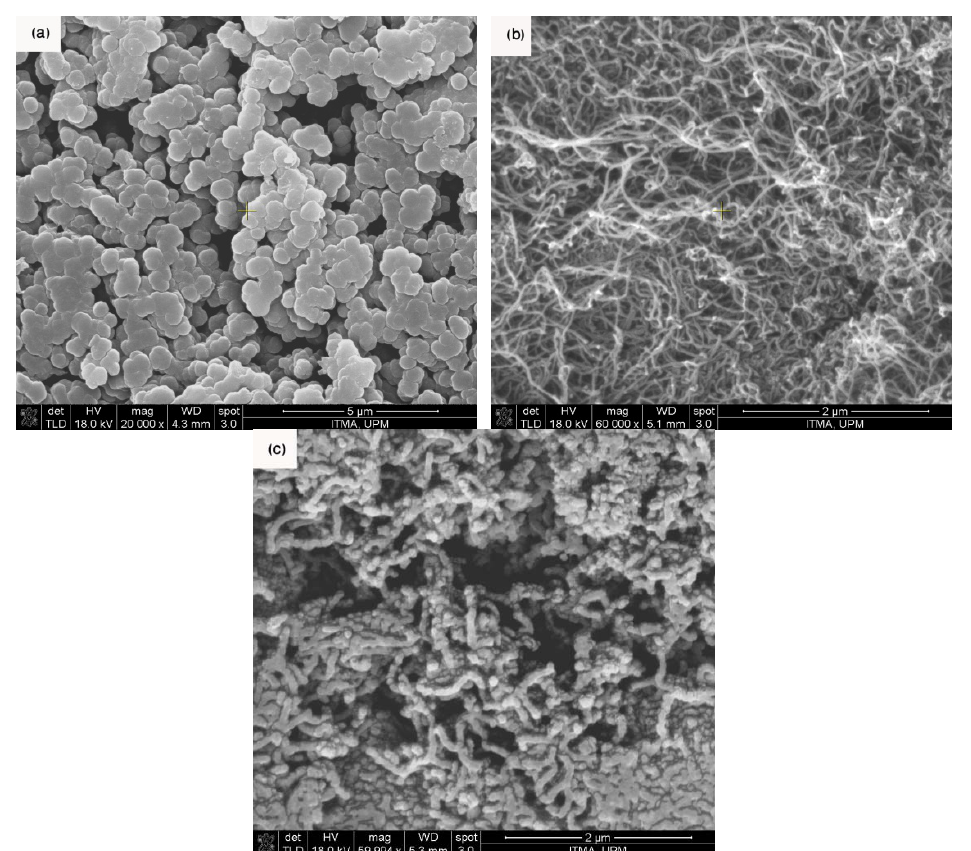
Figure 1. Field emission scanning electron microscopy (FESEM) image of ( a ) the Polypyrrole (PPy) formed by electrochemical polymerization without multi-walled carbon nanotube (MWNT); ( b ) the purified MWNTs; ( c ) the PPy/MWNT nanocomposite formed by electrochemical